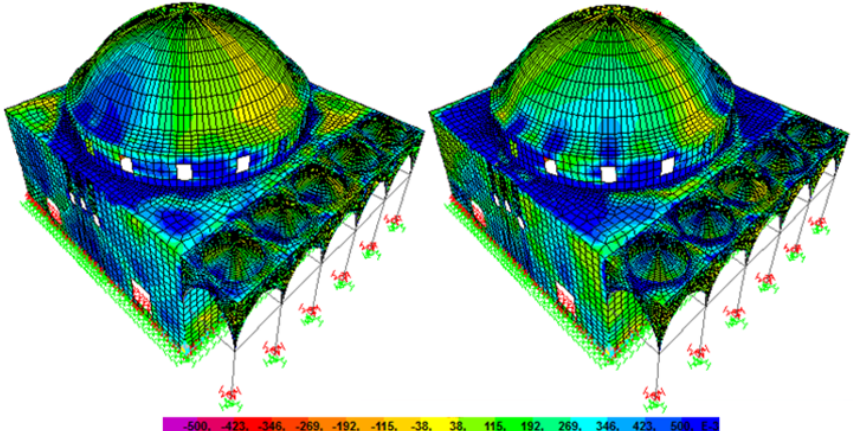
Figure 12. Maximum shear stresses contour diagram for the outer and inner surfaces of the mosque with 16 window openings under dead load and earthquake load (G +